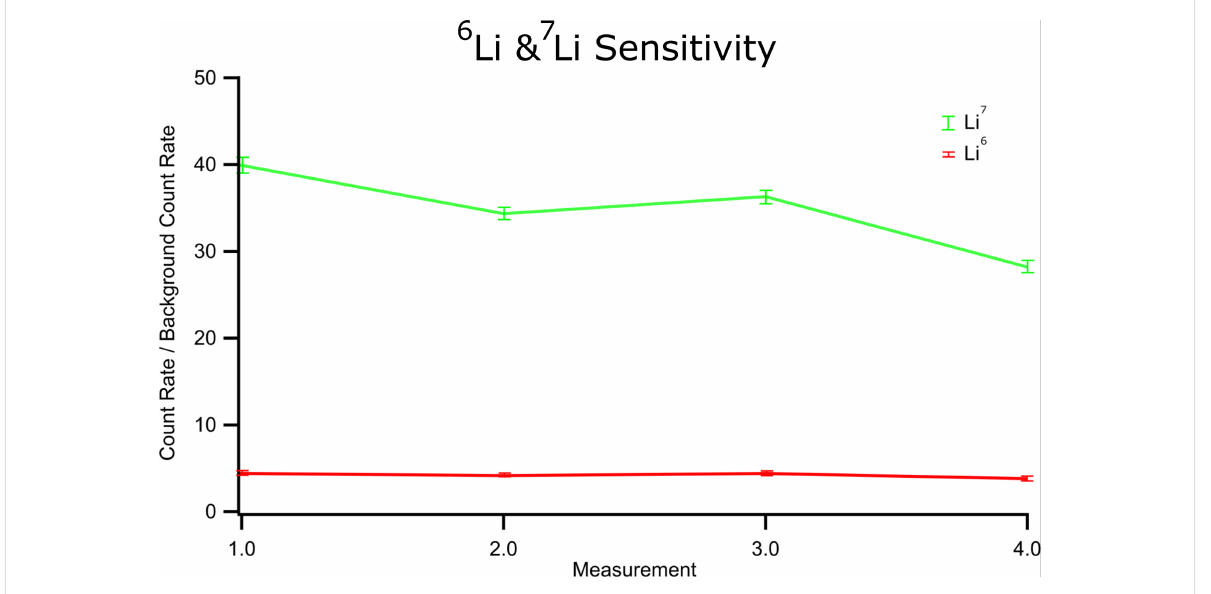
Figure 8: Count rates relative to background count rates for 6 Li (red, 3 μ g/g) and 7 Li (green, 37 μ g/g) for the NIST 612 glass standard. Background counts were collected simultaneously on a detector positioned over a fractional mass/charge ratio with no real